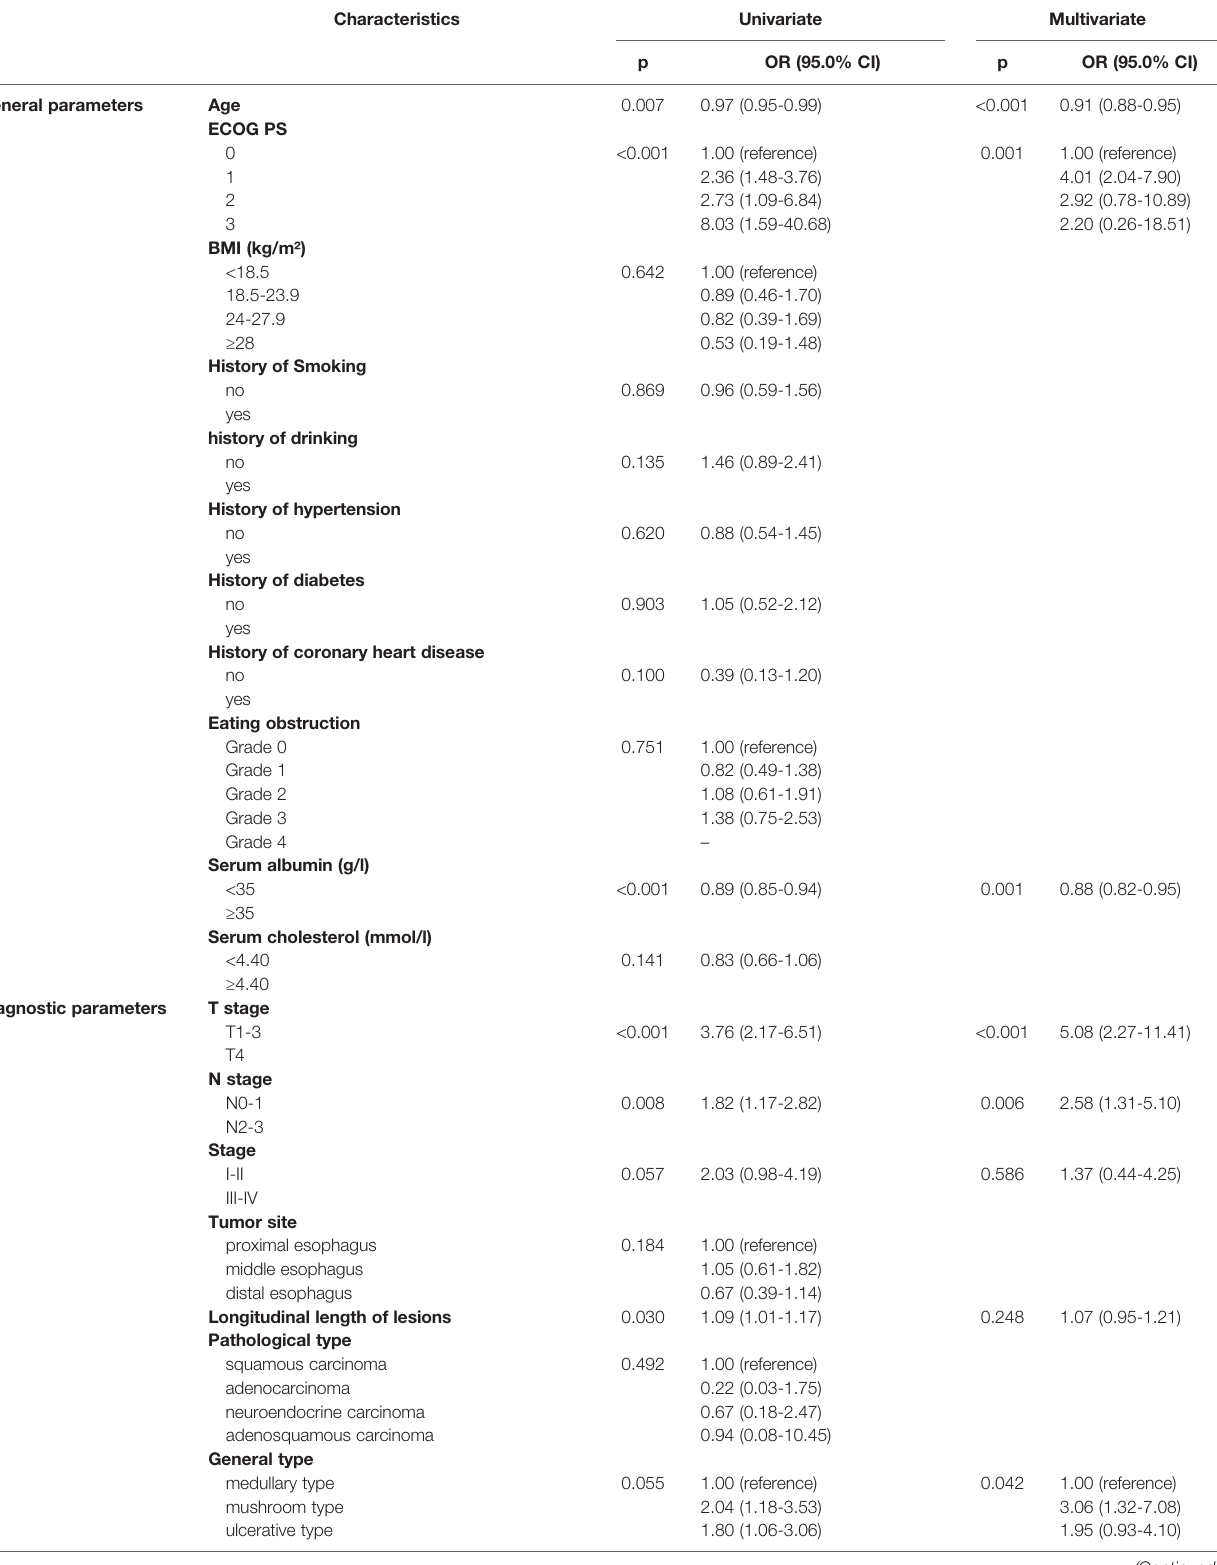
TABLE 3 | Univariate and multivariate logistic regression analysis of clinical characteristics in the training